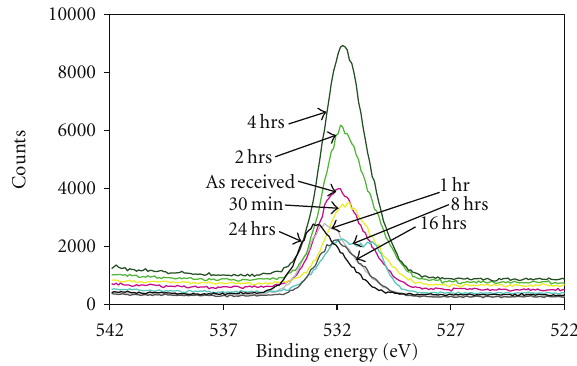
Figure 8: Oxygen region of XPS spectra in untreated and treated bast kenaf fibers.